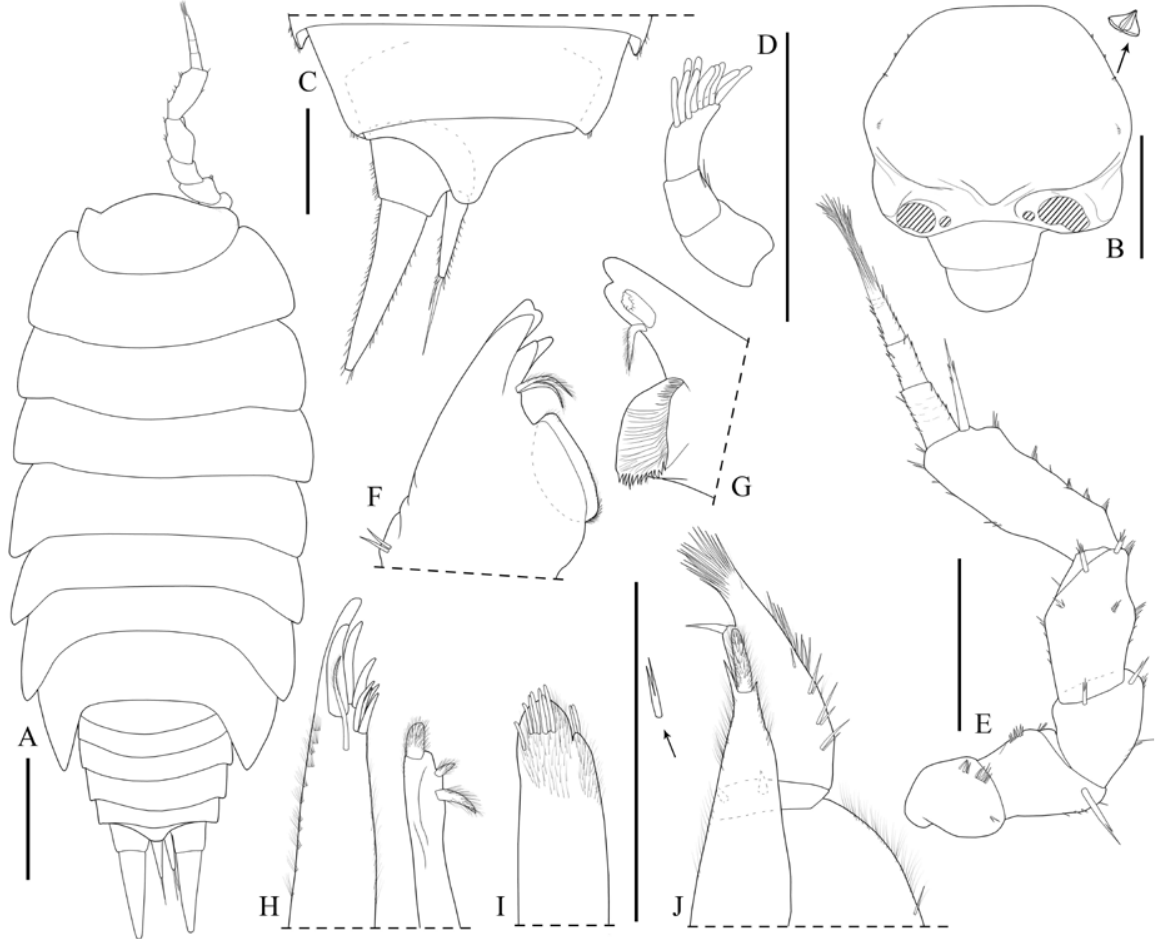
Figure 8. Pectenoniscus iuiuensis n. sp. Male paratype: A , habitus, dorsal view; B , cephalon, frontal view; C , pleonite 5, pleotelson and uropod, dorsal view; D , antennula; E , antenna; F , left mandible; G , right mandible; H , maxillula; I , maxilla; J , maxilliped. Scale bars: A : 0,5 mm; B–J : 0.2